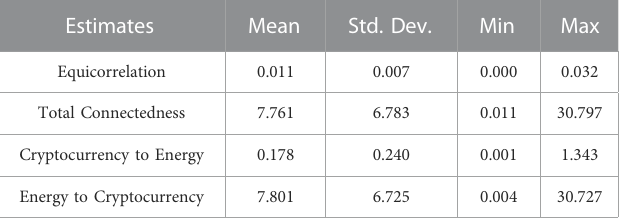
TABLE 3 Absolute difference between baseline estimation and estimation in robustness check (%). Estimates Mean Std. Dev.